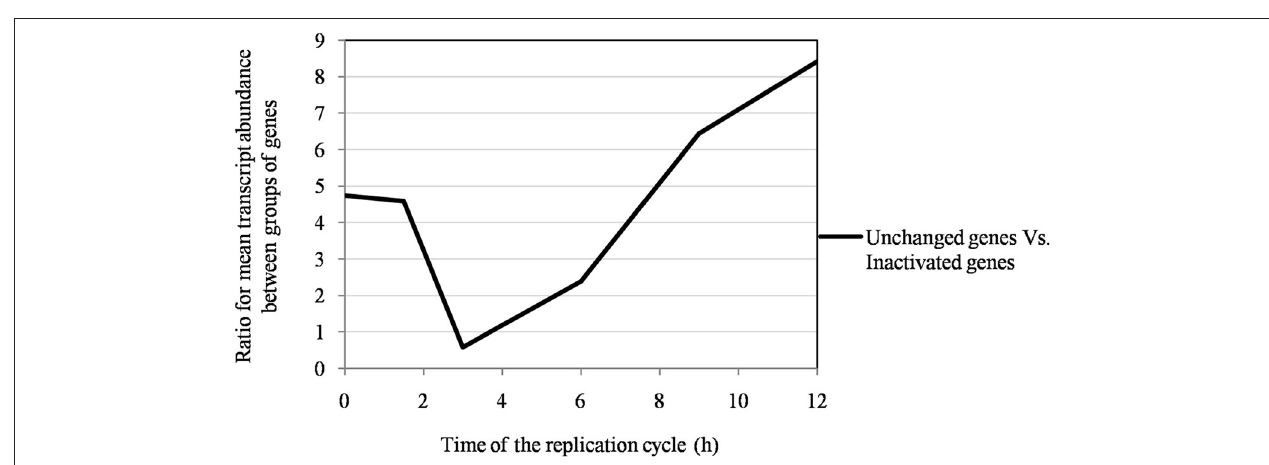
FIGURE 6 | The ratio of the mean transcript abundance in Mimivirus M1 between unchanged and inactivated genes during allopatric laboratory culture on amoebae.